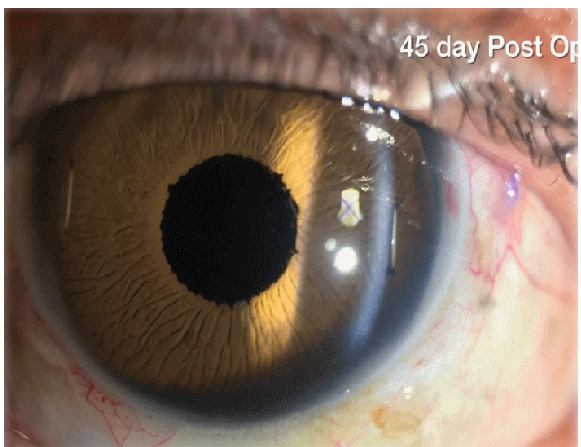
Figure 4: Postoperative appearance at the